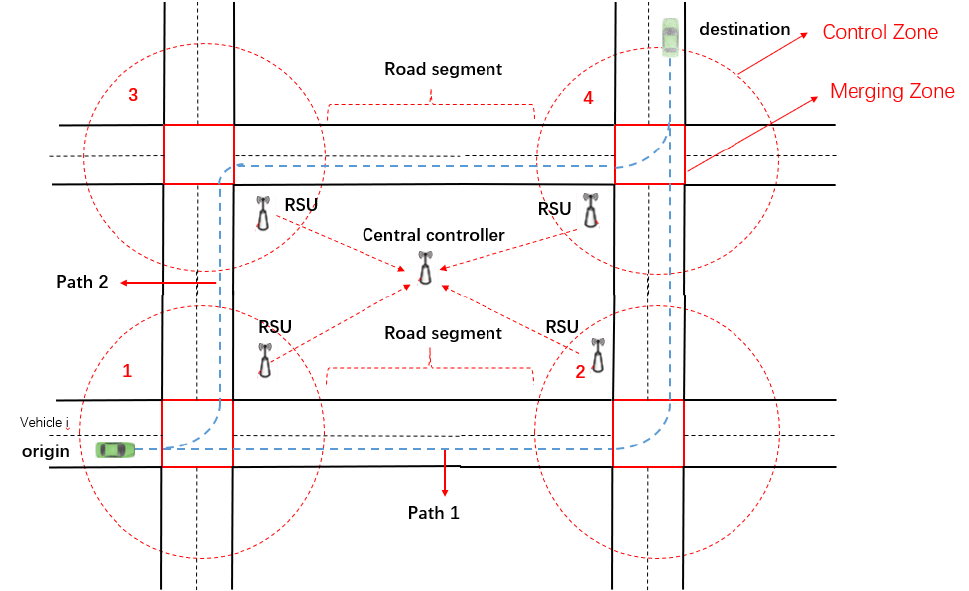
Figure 1. A typical road network with four intersections.